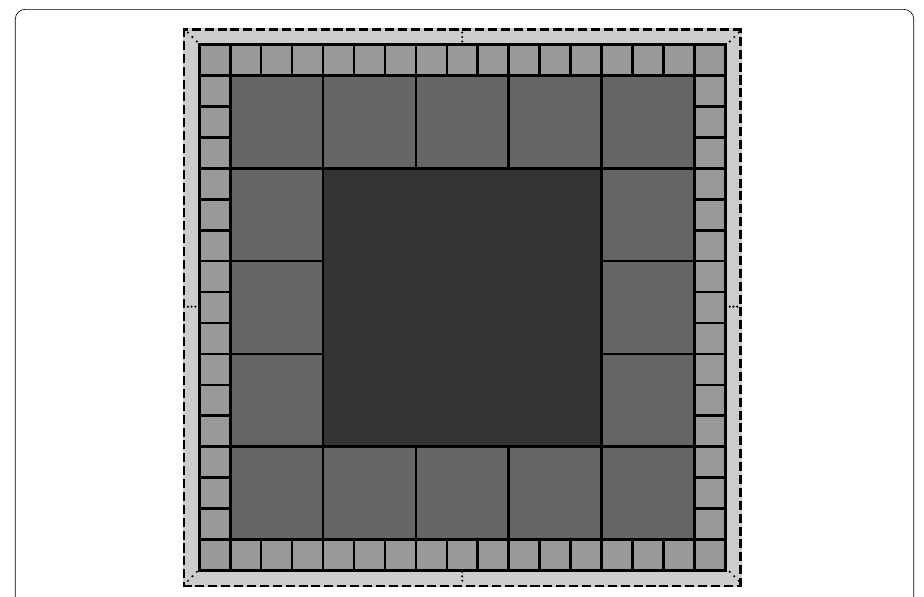
Figure 5 Generalized Whitney subdivision of a square. The first three layers L 0 , L 1 , and L 2 are shown in increasingly lighter shades of gray